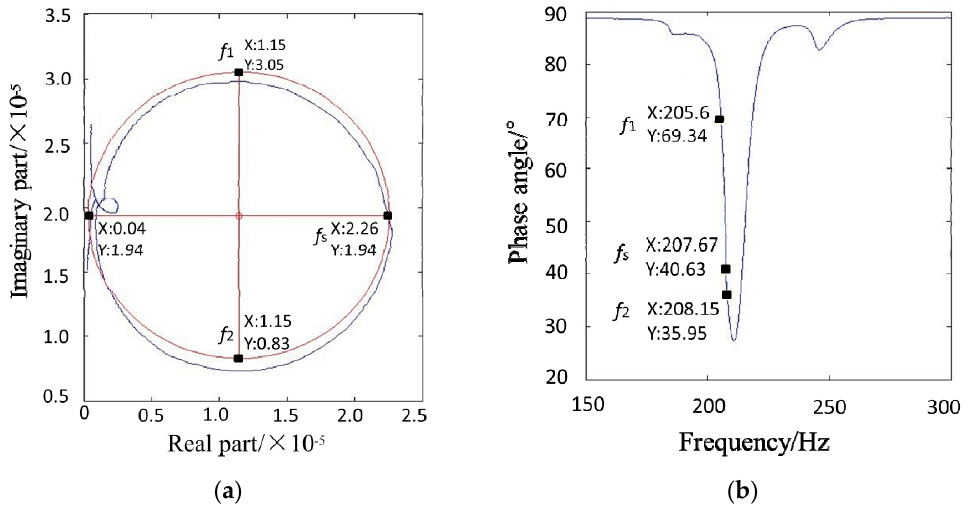
Figure 4. ( a ) Admittance circle curve; ( b ) Phase frequency characteristic curve.